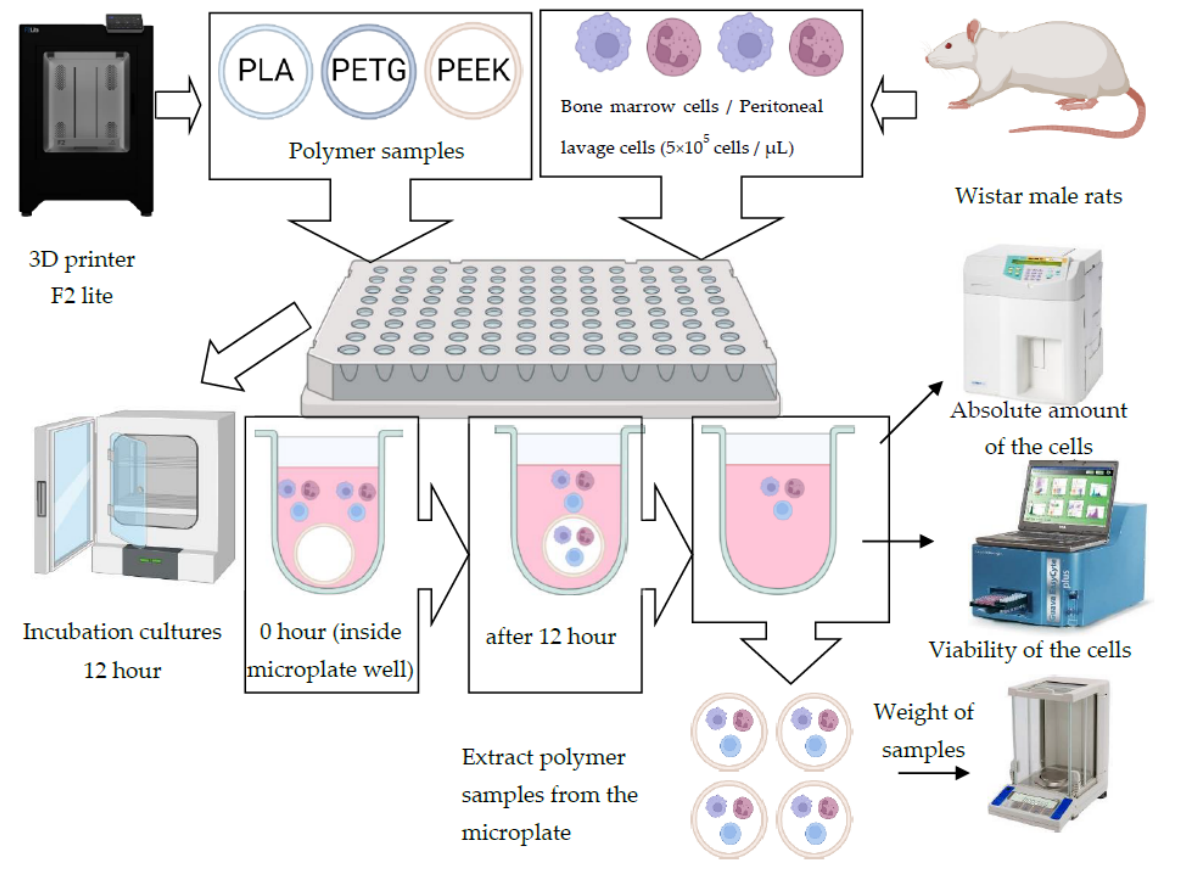
Figure 4. Experiment methodology illustration.